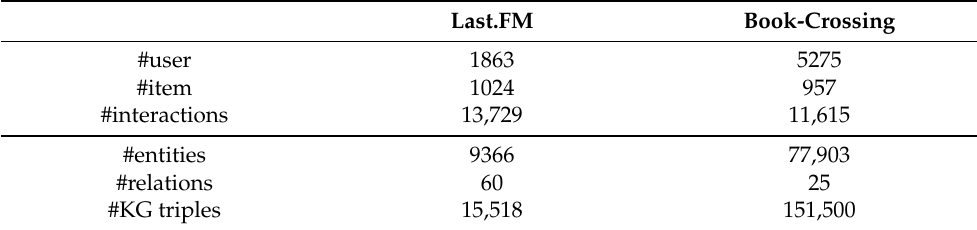
Table 2. Basic statitics for datasets. Last.FM Book-Crossing #user 1863